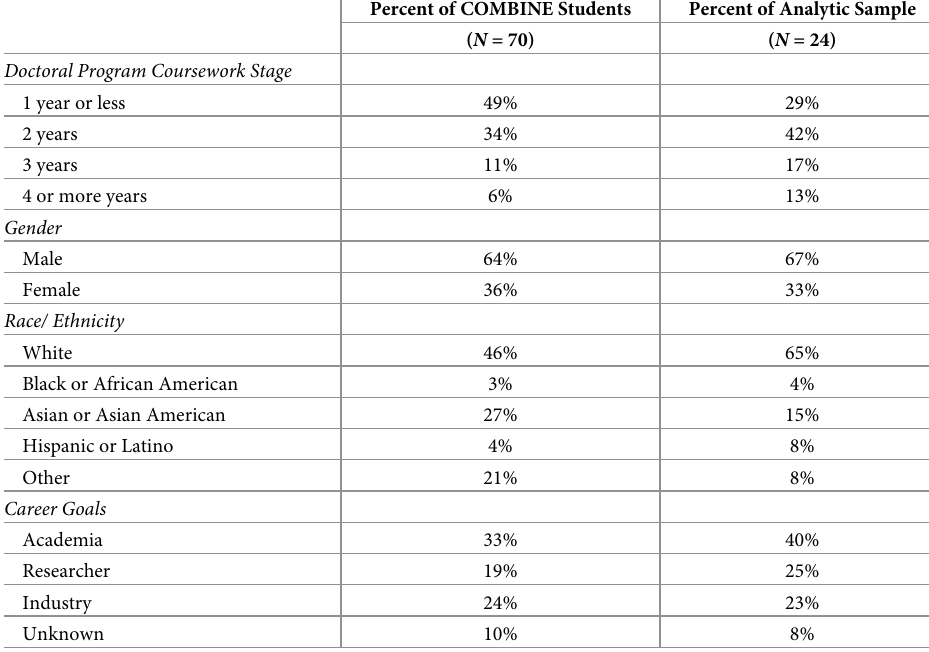
Table 4. COMBINE student demographics upon starting the program.